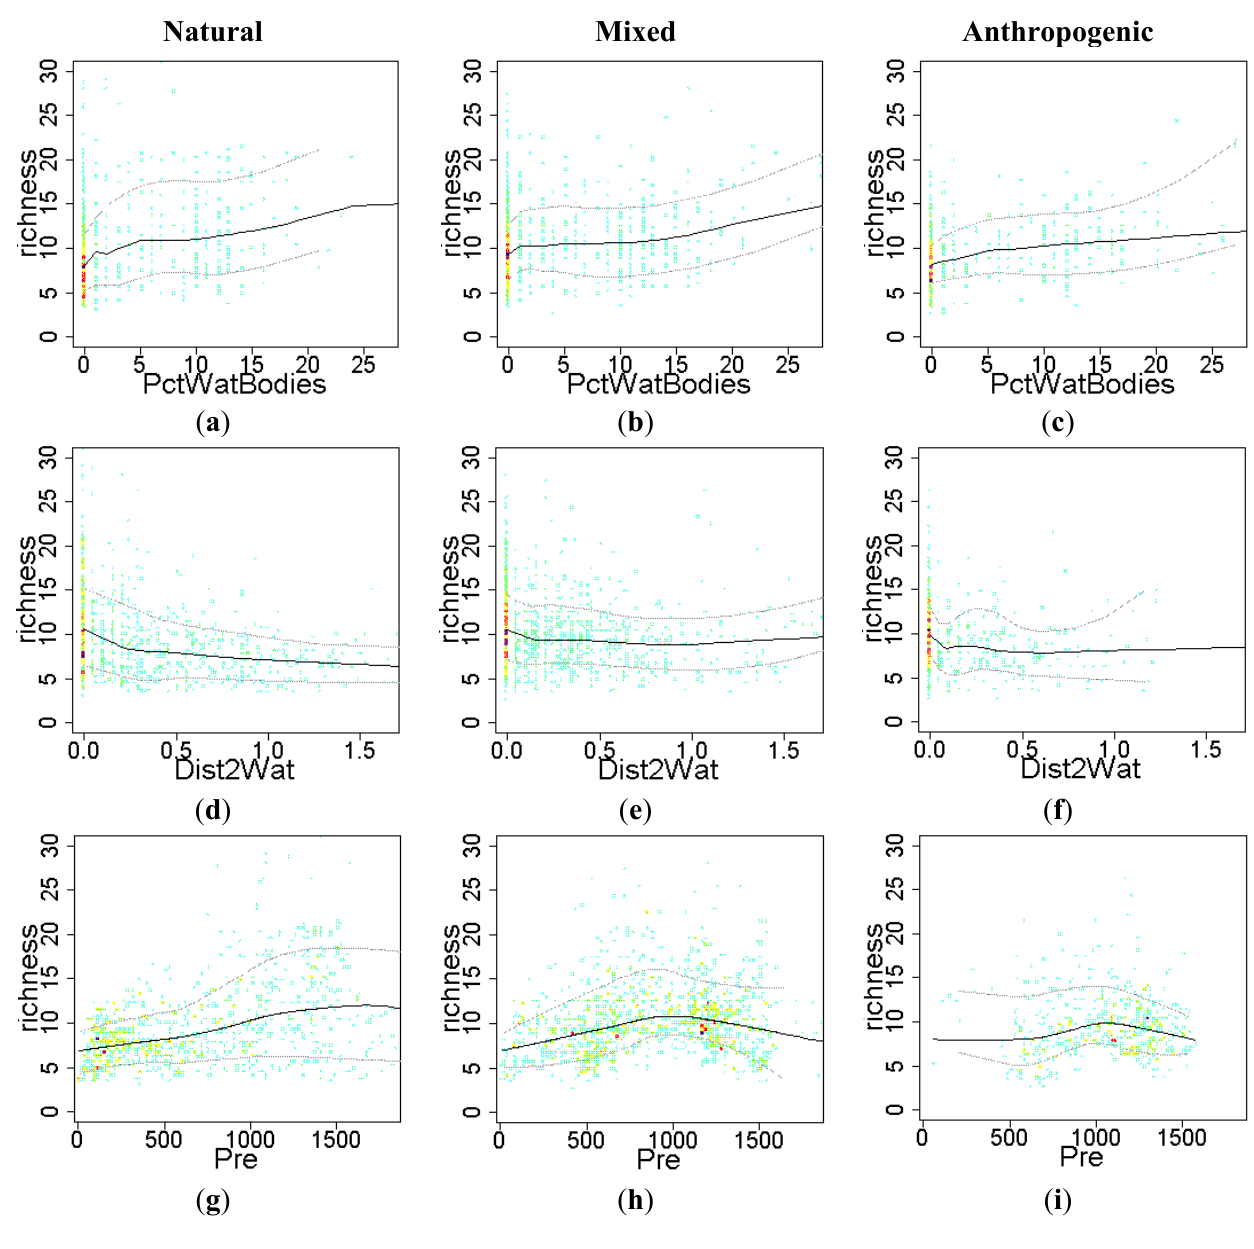
Figure 5. Relationship between EFT richness and “water availability” variables. The sense of the effect was visualized by using warmer colors for high point density and Local Polynomial Regression Fitting (LOESS) on the 10th, 50th and 90th percentile. Relationships were compared across a Human Influence Index (HII) gradient: natural (HII < 10), mixed (10 < HII < 20) and anthropogenic systems (HII > 20). PctWatBodies: % of water